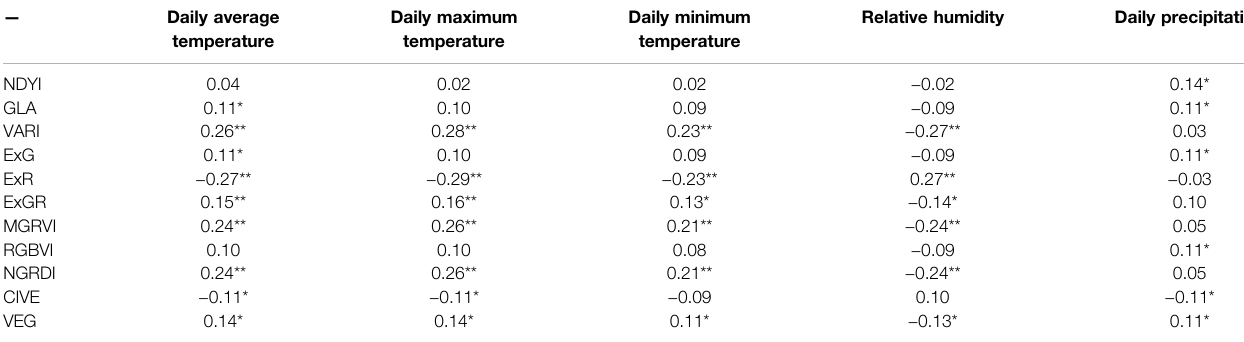
Relative humidity Daily precipitation